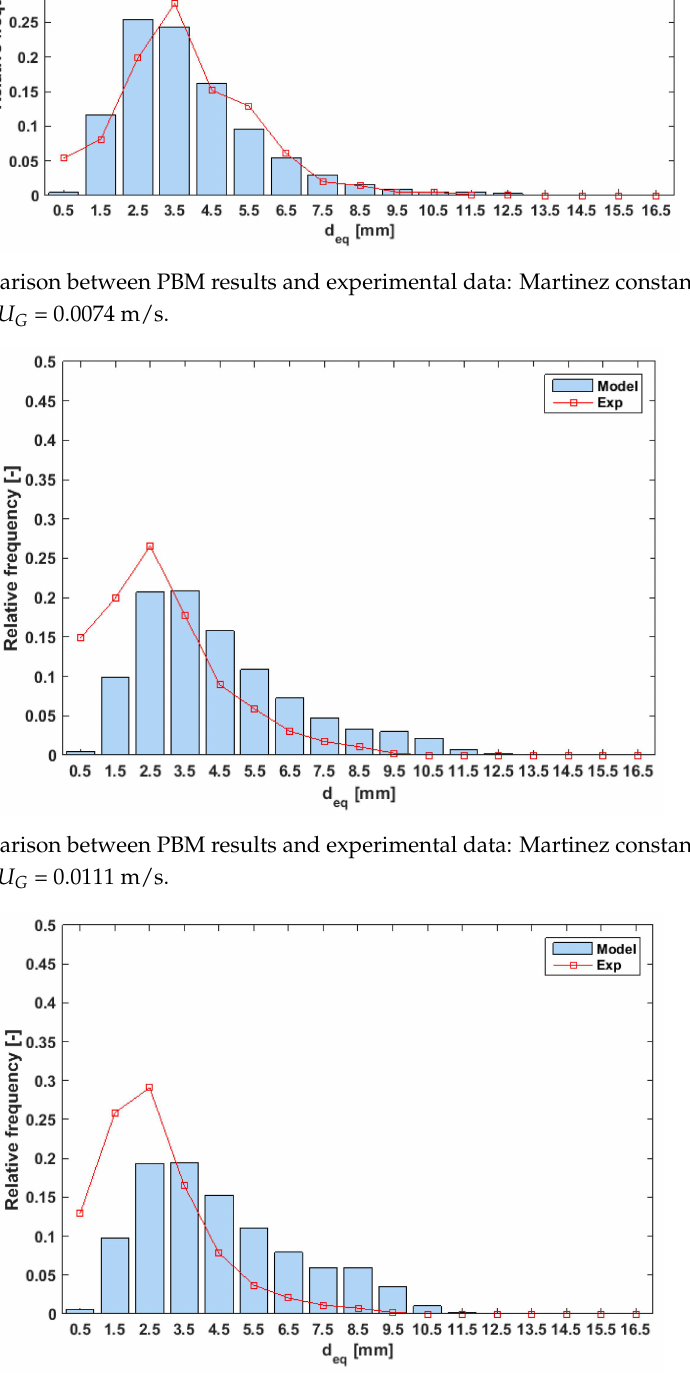
Figure 16. Comparison between PBM results and experimental data: Martinez constant and uniform BSD at the inlet: U G = 0.0149